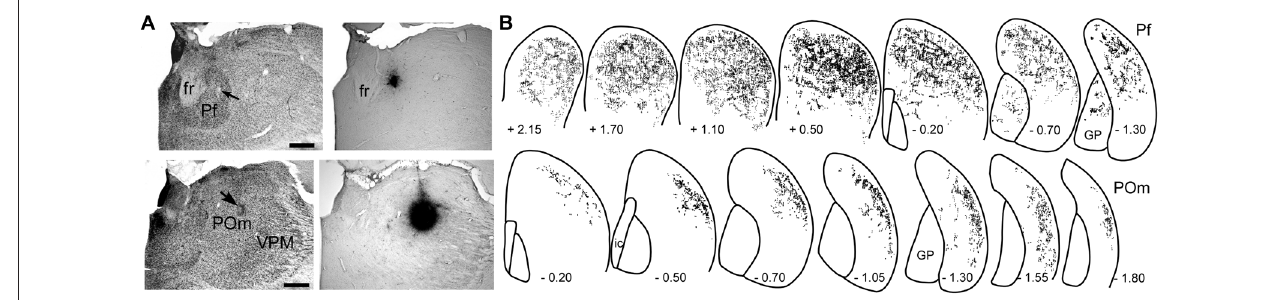
FIGURE 3 | Patterns of striatal innervation revealed by placing an anterograde tracer in Pf (top) or POm (bottom). (A) Photomicrographs of adjacent sections depict cytoarchitecture and biotinylated dextran amine (BDA) deposits in Pf or POm of two different rats. (B) Rostrocaudal series showing spatial distribution of BDA-labeled axonal varicosities in the striatum. Each series based on superimposing reconstructions from three rats that received similar BDA injections in Pf or POm. Numbers indicate distance (mm) from bregma. Scale bars: 500 microns in (A) . Abbreviations: fr, fasciculus retroflexus; GP, globus pallidus; VPM, ventroposteromedial nucleus. Adapted from Alloway et al.